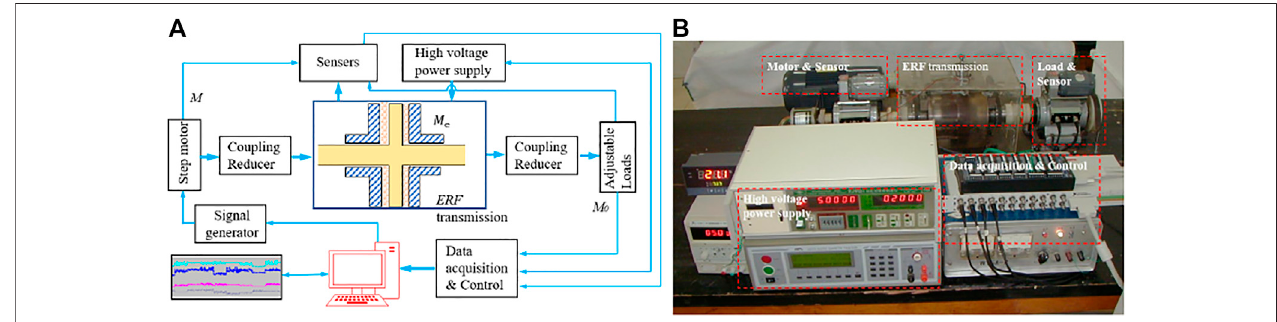
FIGURE 5 | Experimental setup diagram and its photo. (A) is the test principle diagram (B) is the photo of the test platform.